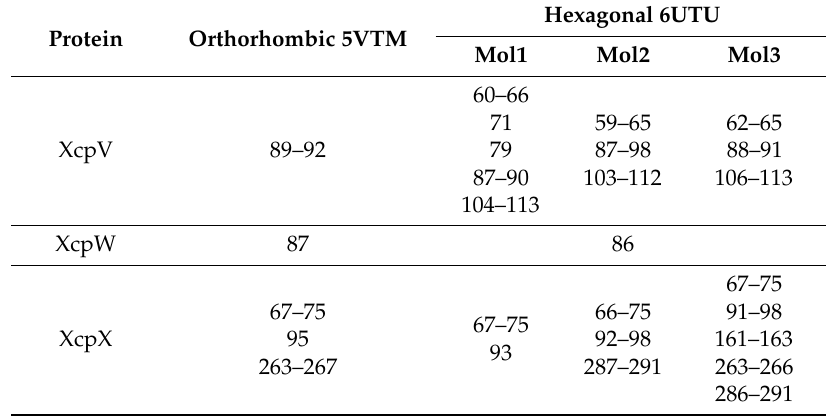
Table 2. Missing residues in